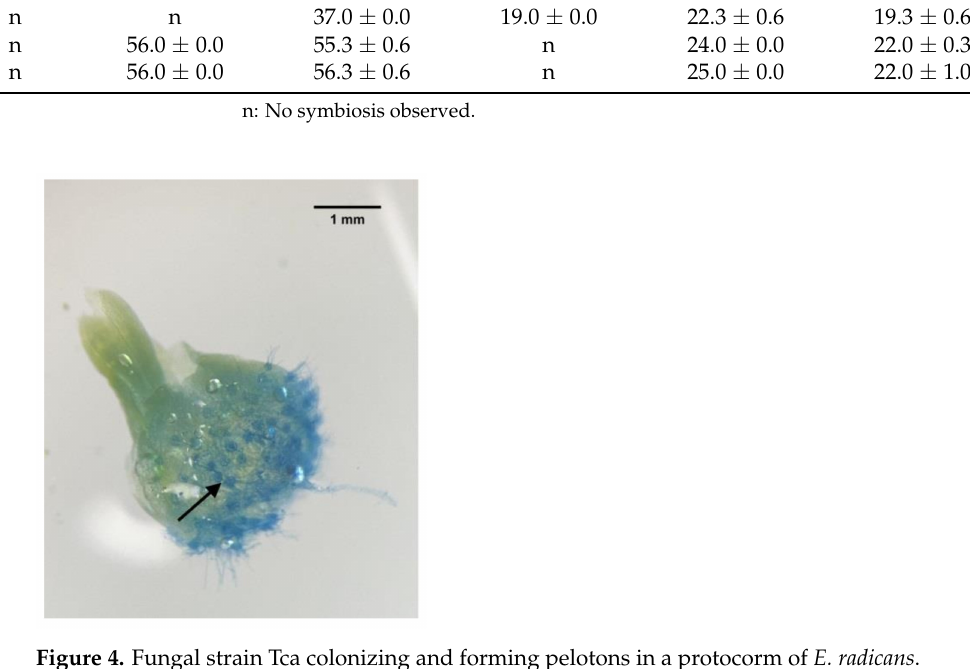
Figure 4. Fungal strain Tca colonizing and forming pelotons in a protocorm of E. radicans . For C. mannii , Tbi could not form pelotons at any of the OA concentrations. The time of detection of Tca pelotons varied from 20.3 ± 0.6 (2.0 g/L OA) to 56.3 ± 0.6 days (12.0 g/L OA), whereas that of Tas was 56.0 ± 0.0 days at 8.0 and 12.0 g/L OA. The peloton-forming times of the strains Tbi, Tas, and Tca in E. radicans varied depending on the concentrations of OA. The shortest time was for Tbi (18 days) at 2.0 g/L OA, and the longest time was for Tas (25 days) at 12.0 g/L OA. Tca and Tas could colonize both orchid hosts, whereas Tbi only formed pelotons in E. radicans